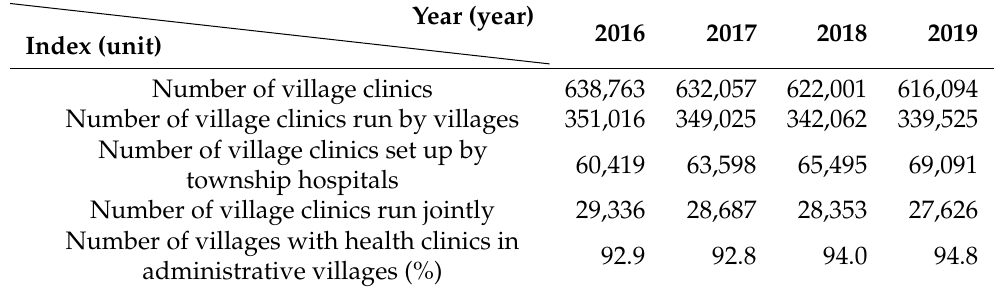
Table 1. Village health